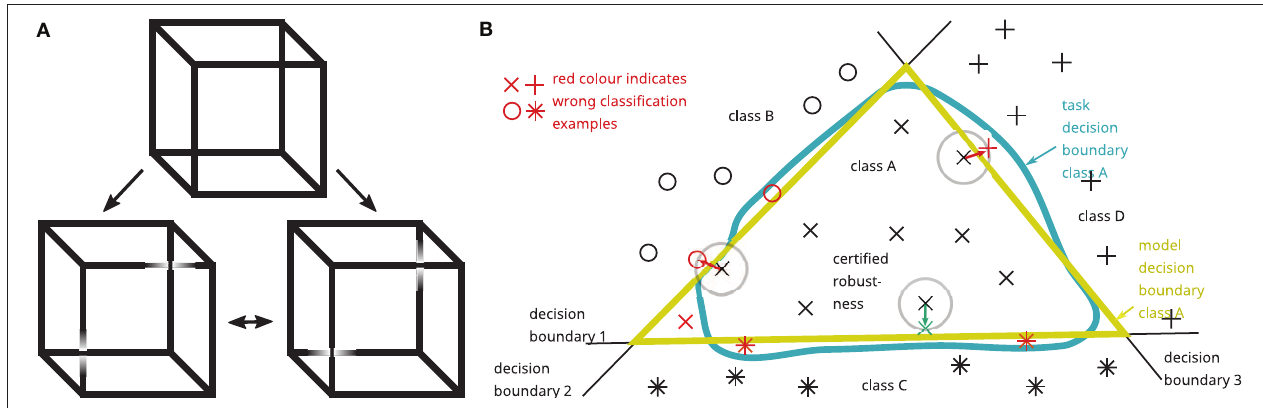
FIGURE 6 | Error-prone decision-making in humans (A) and AI systems (B) as exemplified by the Necker cube as an example of an ambiguous image (A) and a schematic depiction of adversarial examples in a 2D-projection of state space (B) . Task and model decision boundaries do not perfectly match and small changes in input may result in large changes in output. More details are given in the main text.